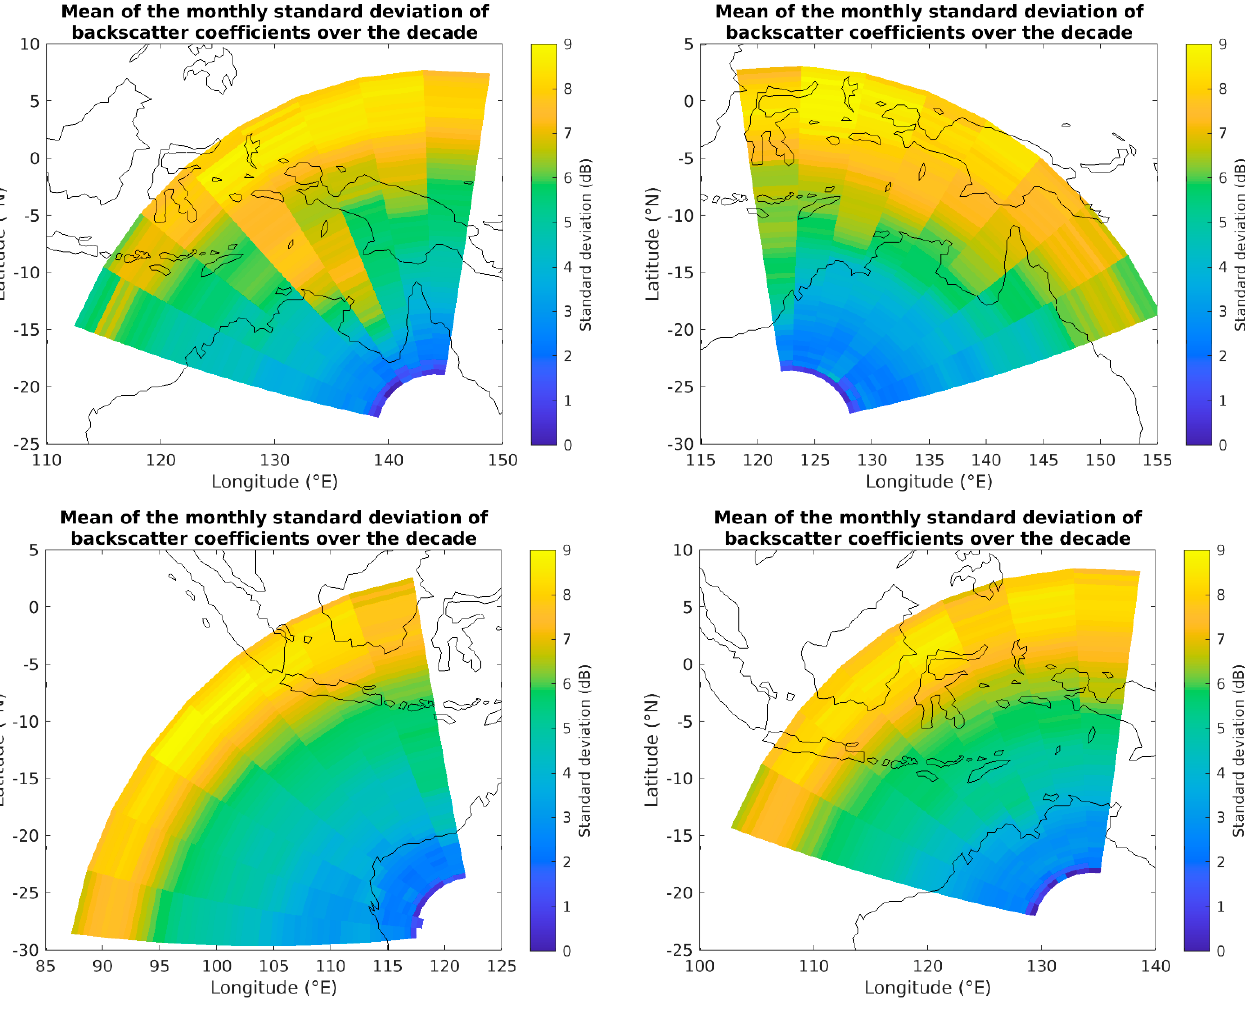
Figure 6. The decade mean of the standard deviation of each monthly value for LO ( top left ), LAE ( top right ), LAW ( bottom left ) and AS ( bottom right ).